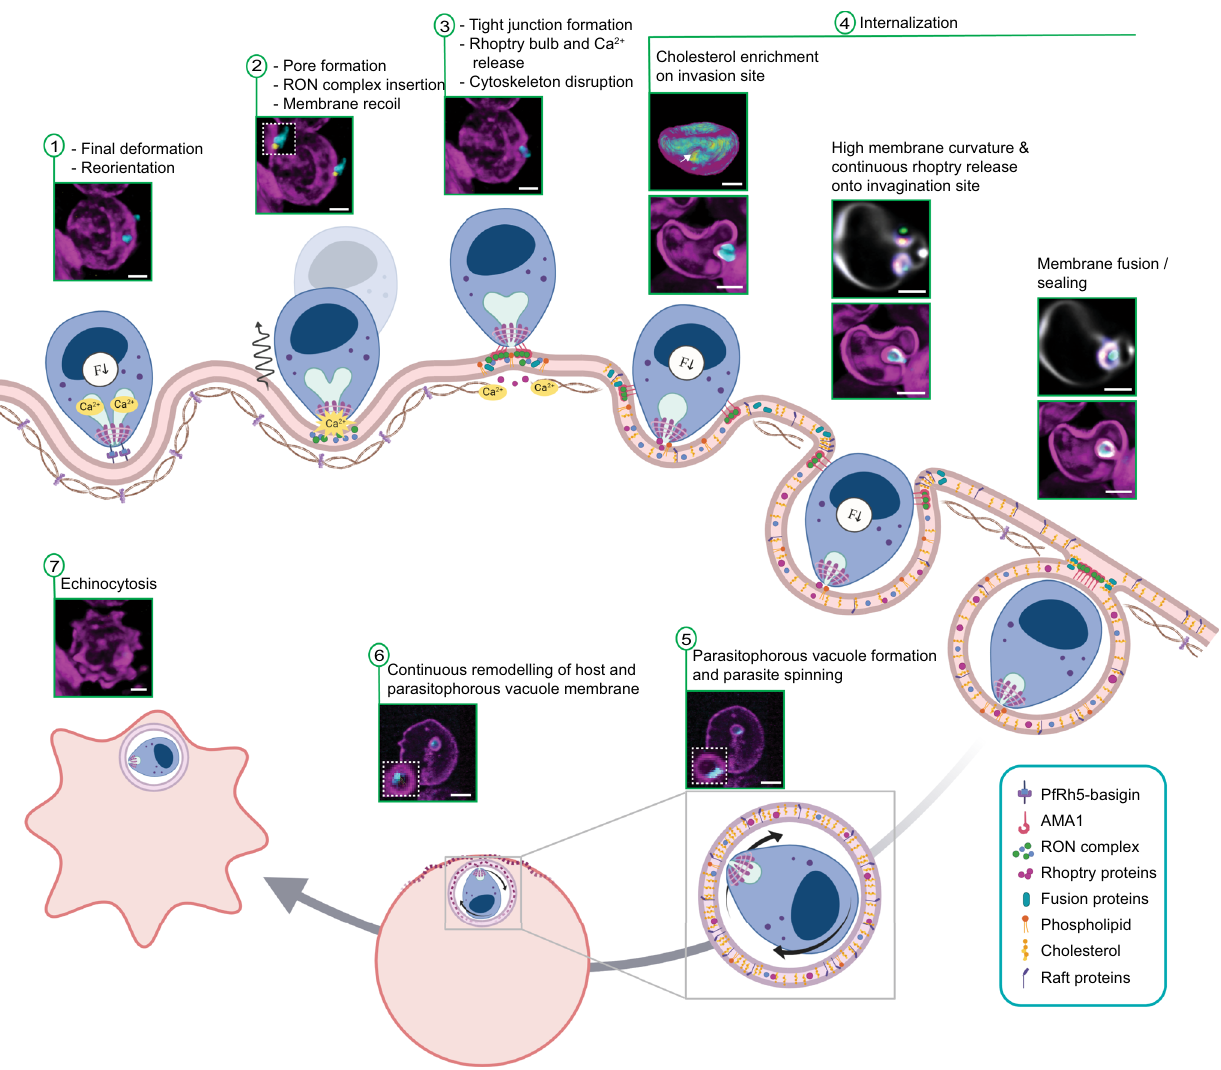
Fig. 6 Re fi ned model for invasion. (1) Upon egress, the merozoite deforms a nearby erythrocyte multiple times until a reorientation of the merozoite is achieved and its apical tip is anchored to the host membrane via PfRh5 – basigin interaction. (2) Following this interaction, a fusion pore is formed at the parasite-host junction, and RON complex is inserted into the erythrocyte membrane as the parasite pulls back. (3) A tight junction is then formed as the parasite binds the RON complex with AMA1. Coincidentally, the parasite releases Ca 2 + , proteins, and lipids, from its rhoptry, which is followed by the disruption of the erythrocyte cytoskeleton underneath the parasite-host interface. (4) As the parasite begins to internalize, cholesterol is recruited to this site to sustain high curvature at the aperture of the invasion site. The energetic contributions of cholesterol accumulation, cytoskeleton disruption, and parasite motor engagement allow the merozoite to be completely wrapped by the remodeled host membrane. The presence of cholesterol enables membrane fusion to seal invagination ori fi ce and facilitates host detergent-resistant membrane-associated proteins recruitment into the PVM. (5 – 6) Upon invasion, the parasite spins inside the vacuole and the PVM continues to be enriched in cholesterol and other parasite-derived materials. (7) Eventually, the continuous membrane remodeling induced by the parasite causes the host cell to undergo echinocytosis (created with BioRender.com). Snapshots taken from multiple live-imaging experiments. Scale bars: 2 µ